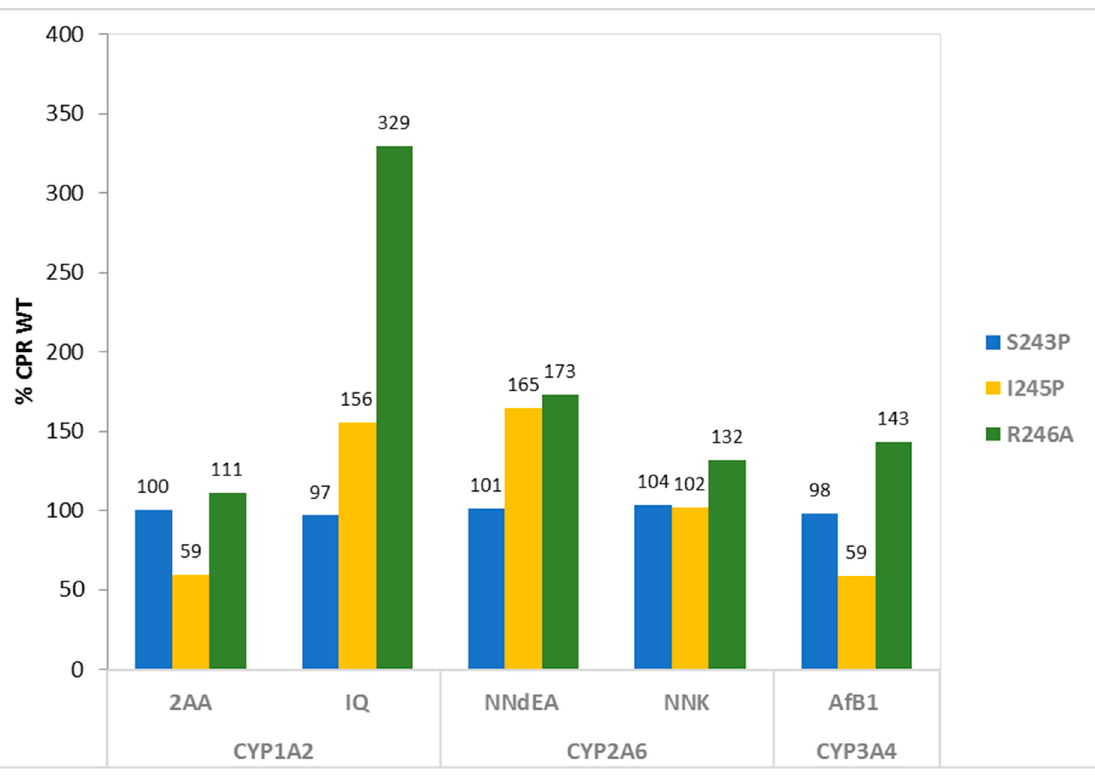
Figure 1. Bioactivation of pre-carcinogens mediated by CYP 1A2, 2A6 or 3A4 when combined with the three CPR hinge mutants. Bioactivation capacities were normalized with the one observed when